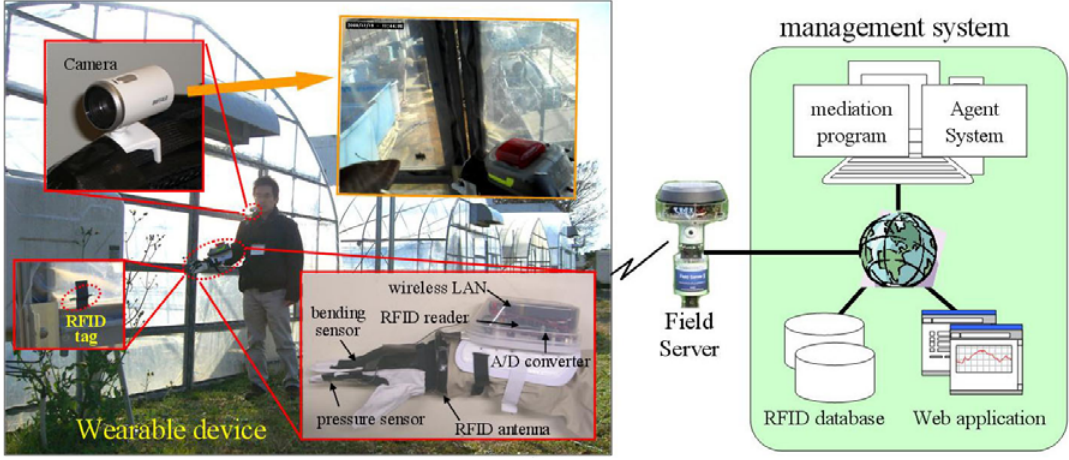
Figure 3. Architecture of farm operation monitoring system.